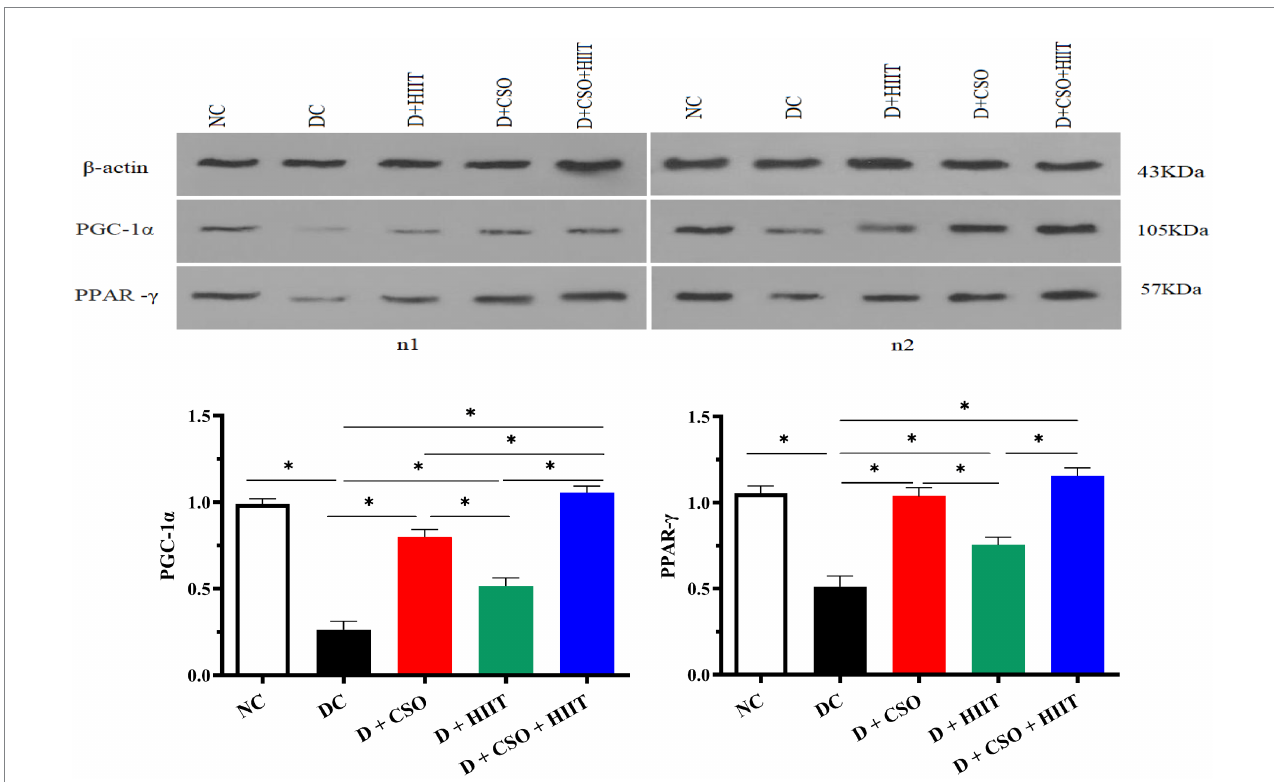
FIGURE 3 Western bloting analysis of protein expression of β -actin, PGC-1 α , and PPARy. The effect of D, D + CSO, D + HIIT, and D + CSO + HIIT on PGC-1 α , and PPARy. NC, Normal control; DC, Diabetic control; D + CSO, Diabetic + camelina sativa oil; D + HIIT, Diabetic + HIIT; D + CSO + HIIT, Diabetic + camelina sativa oil +